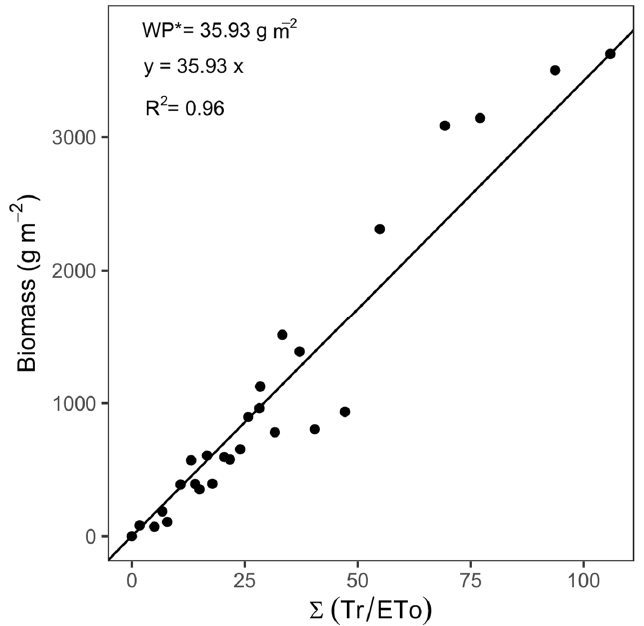
Figure 5. Cumulative biomass and cumulative transpiration (normalized for ET 0 and CO 2 ) for the Guinea grass ( Megathyrsus maximus cv. Agrosavia sabanera) fields (black dots). The black line represents the WP* of 35.93 g m − 2 .